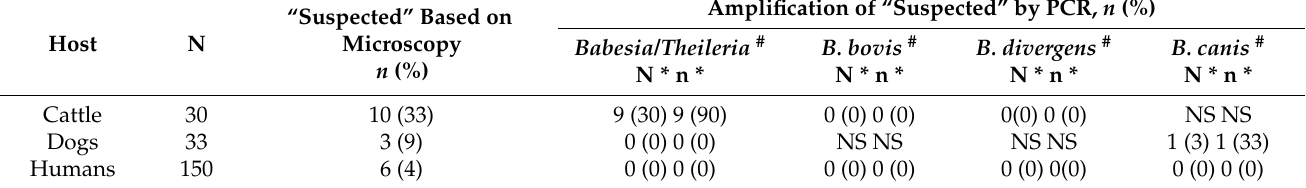
Table 3. Outcome of microscopy and polymerase chain reaction (PCR) examinations for the vari- ous